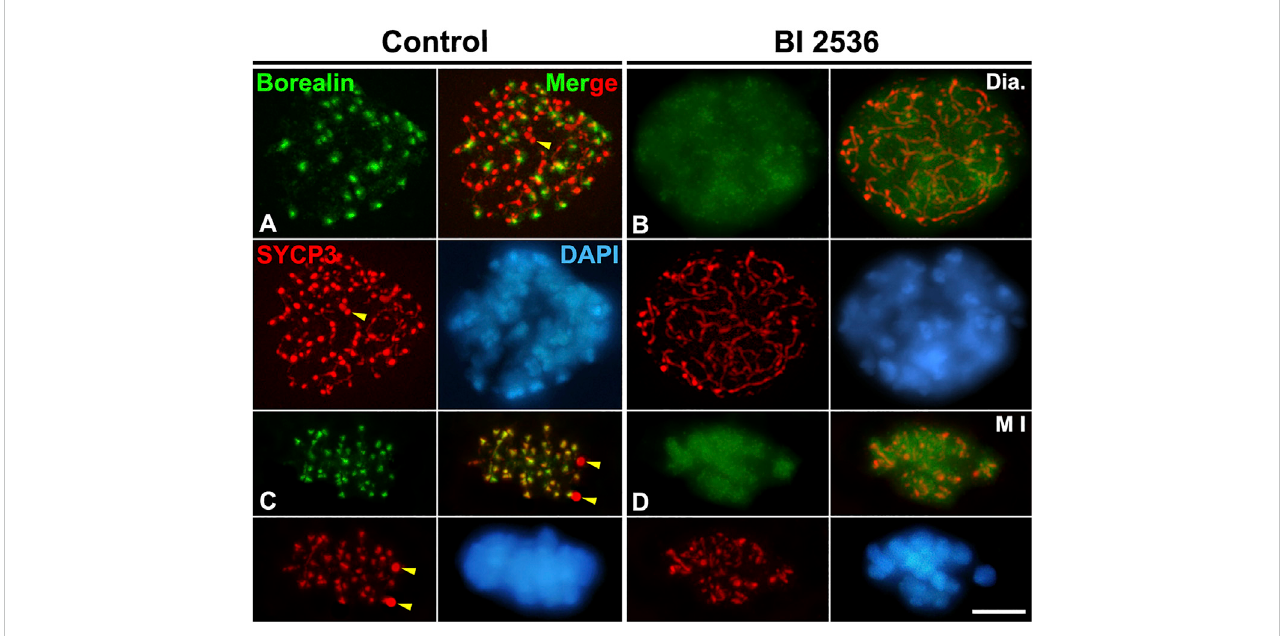
FIGURE 9 PLK1regulatestheloadingofBorealinto theinnercentromeres. Double immunolabelingofBorealin(green)andSYCP3 (red),andcounterstainingofthe chromatin with DAPI (blue) on squashed diakinesis (Dia.) (A) and metaphase I (M I) (C) control spermatocytes, and diakinesis (B) and metaphase I (D) BI 2536- treated spermatocytes. Yellow arrowheads indicate SYCP3 agglomerates in the nucleoplasm and cytoplasm of the control diakinesis and metaphase I spermatocytes, respectively. Scale bar represents 5 μ